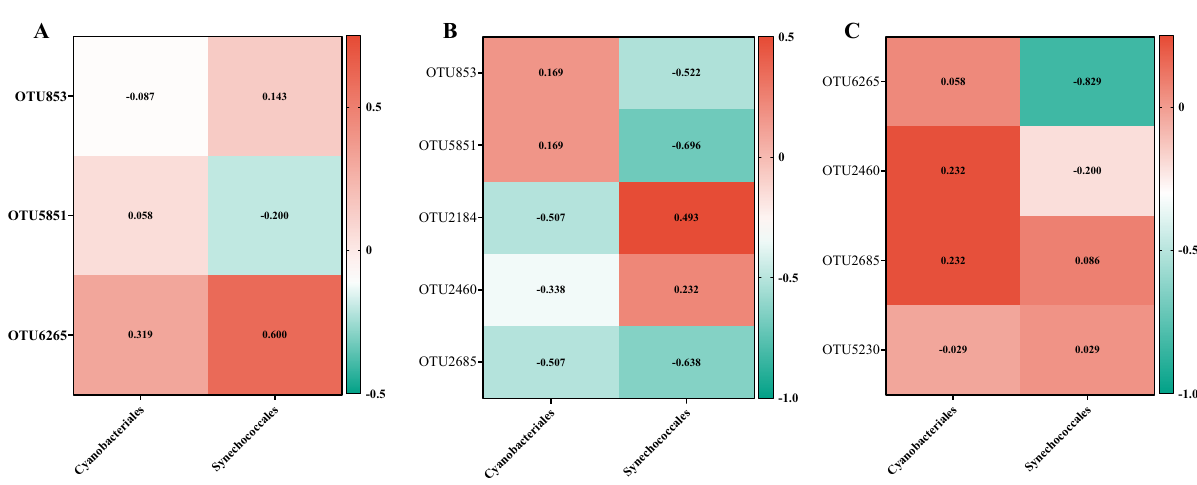
Figure 7. Correlation analysis between dominant cyanobacterial taxa and significant bacterial species (OTUs) identified in JFZ ( A ), SH ( B ), and XH ( C ). Digits in boxes of the heatmap represented the correlation